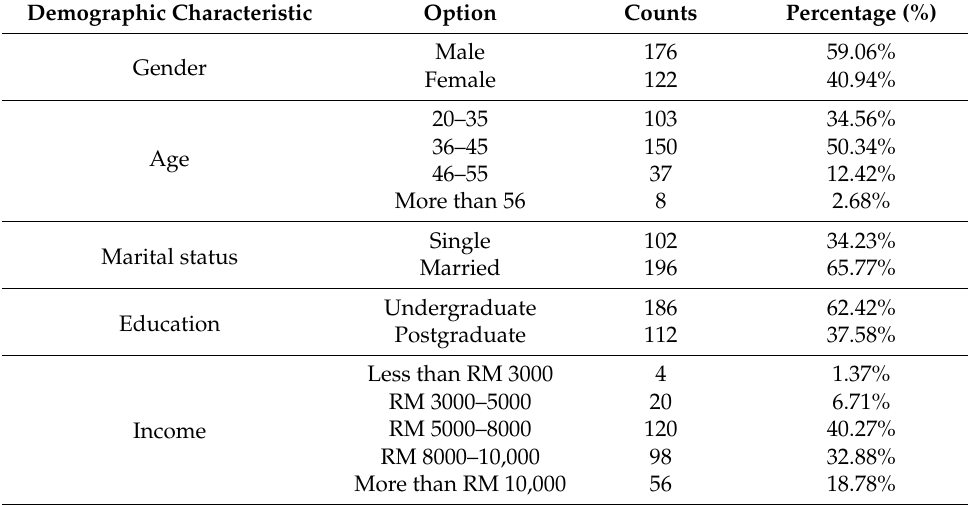
Table 2. Demographic